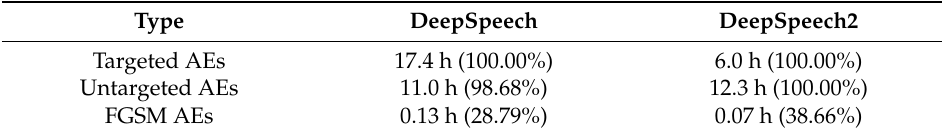
Table 3. Total time taken for generating the audio AEs and their success